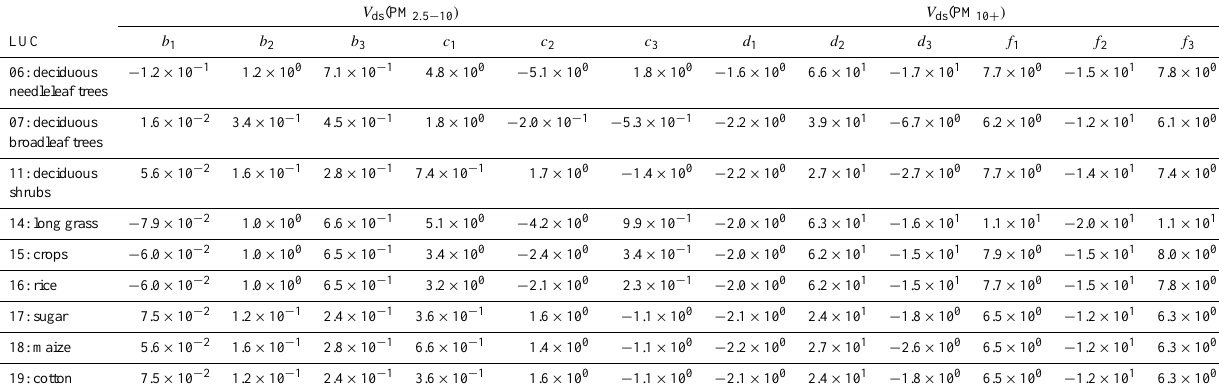
Table 2b. Empirical constants for use in Eqs. (8) and (11) for Category 2 LUCs. V ds (PM 2 . 5 − 10